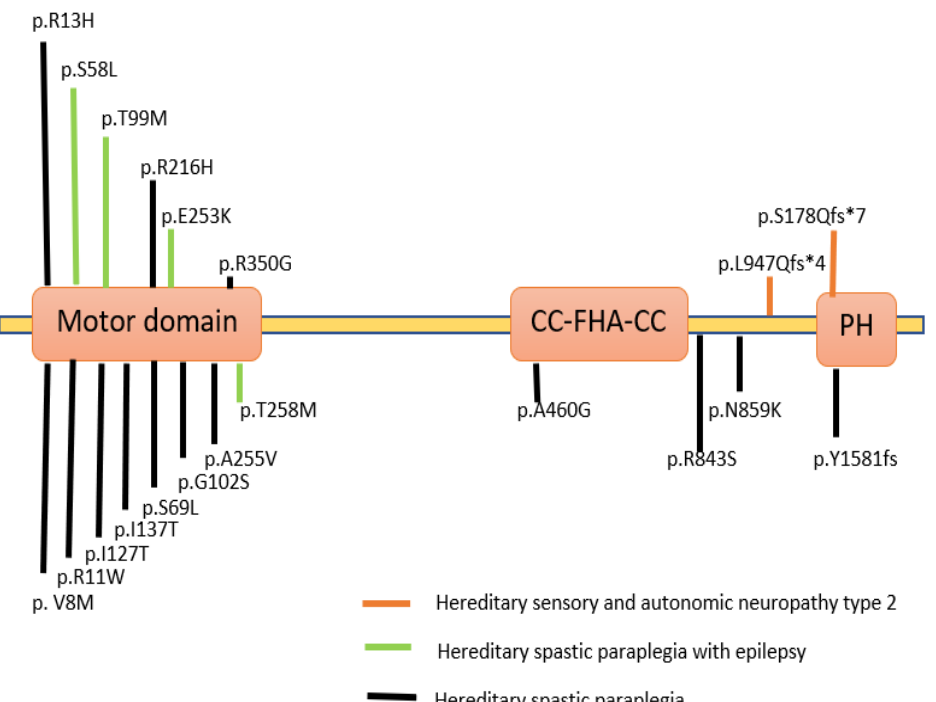
Figure 3. KIF1A protein depicted schematically, along with the locations of mutations in human KIF1A linked to several neurological diseases. The KIF1A subunit protein peptide contains these mutations in a variety of regions and domains [20–23]. (Created with Biorender.com).